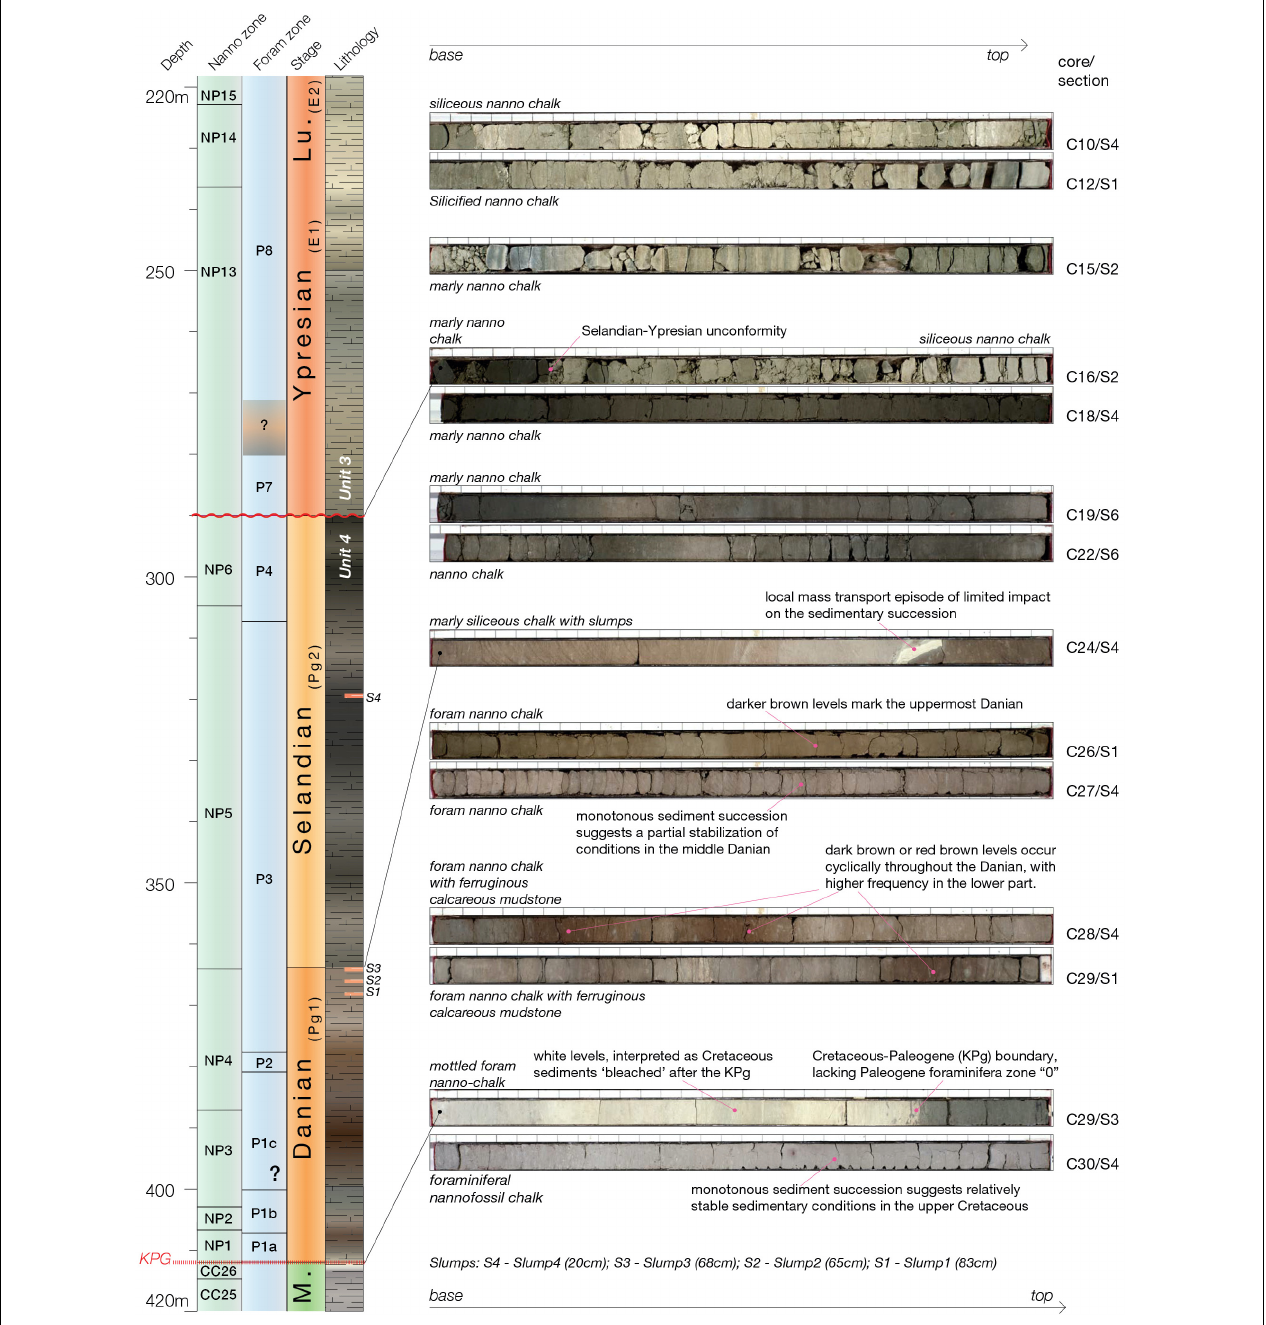
FIGURE 2 | Biostratigraphic zonation and lithological characteristics of the Paleogene succession at the Deep-Sea Drilling Project (DSDP) Site 356, with a selection of images representative for the sedimentary succession, taken during DSDP Leg 39 and their corresponding initial descriptions (in italics) (Perch-Nielsen et al., 1977), with added observations. Pink markers in Unit 4 (S1–S4) indicate intervals where slumps have been described.